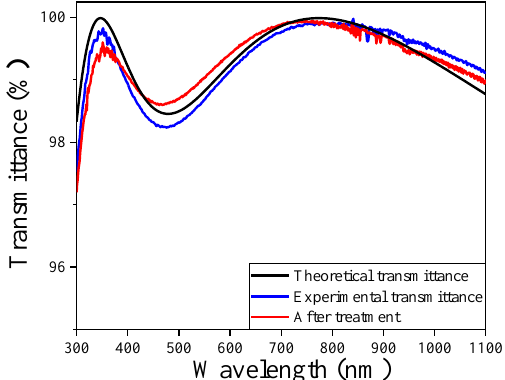
Figure 8. The transmittance spectra of double-layer tri-wavelength AR coating.